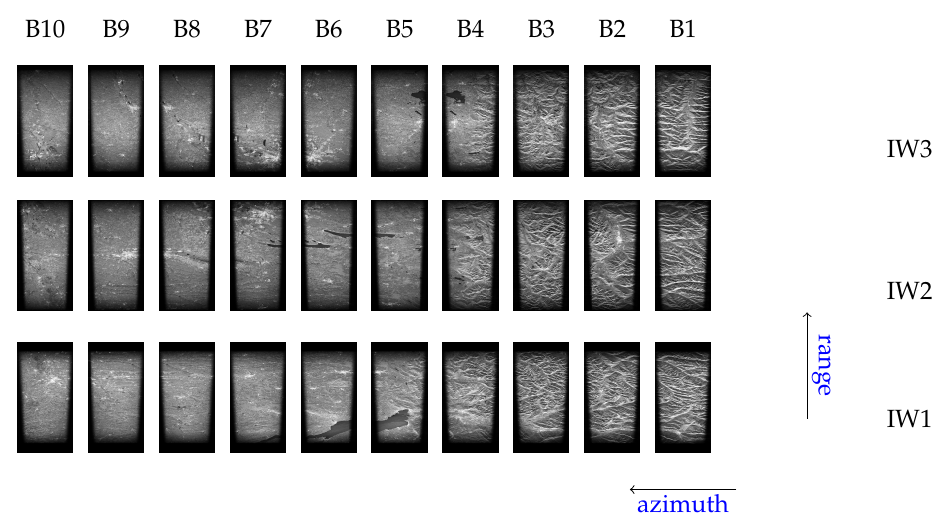
Figure 8. TOPS image focusing result: burst images sequence of the Sentinel-1B raw dataset acquired on 1 January 2019 on the area of interest.